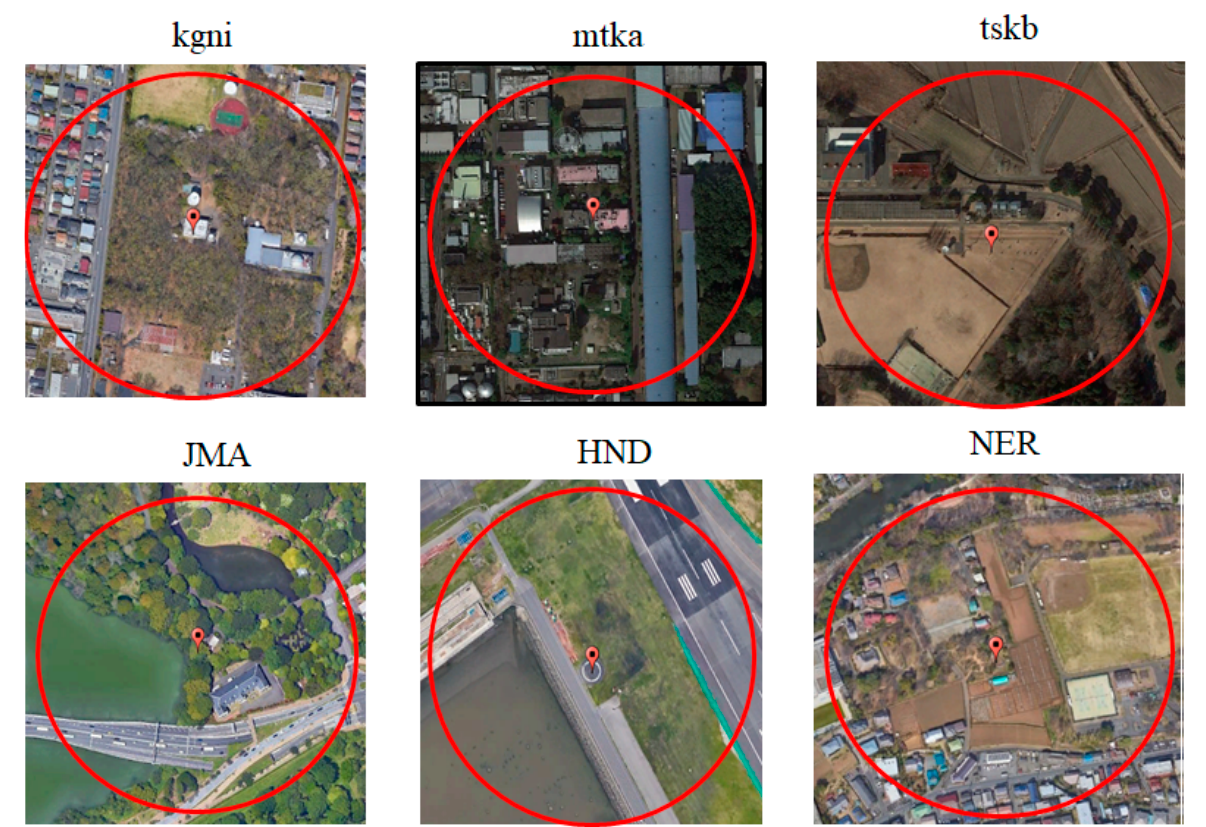
Figure A1. Surroundings of all GNSS and meteorological stations in Tokyo, Japan.